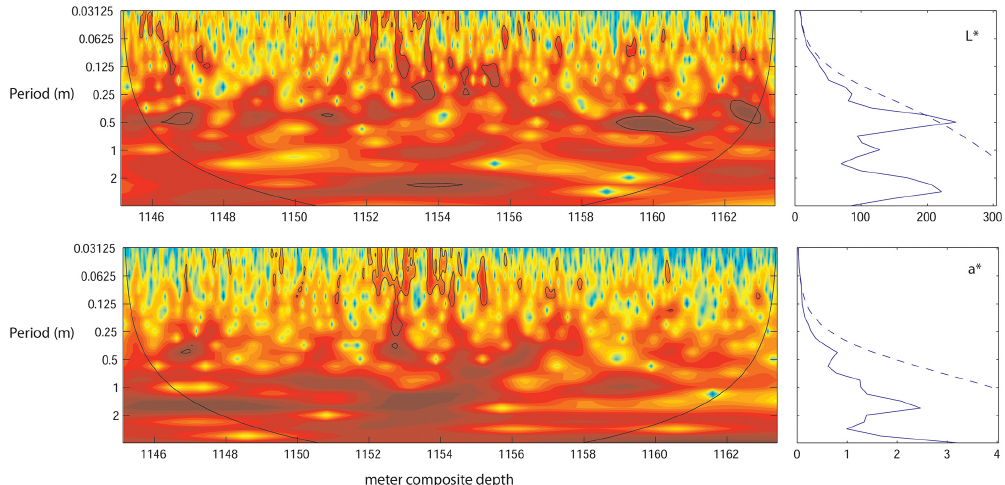
Figure 5. Wavelet plots of the long record of L ∗ and a ∗ showing the confidence of cyclicity per period.